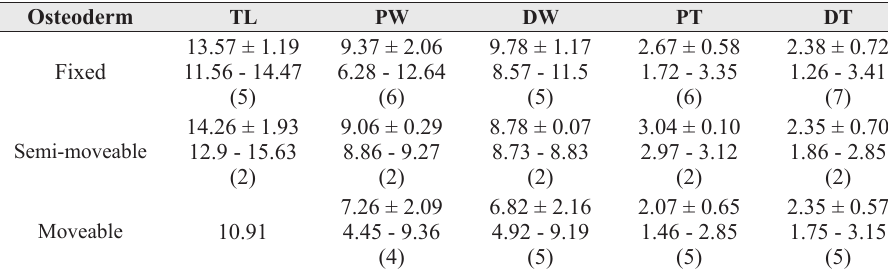
Measurements (mm) of preserved osteoderms assigned to Euphractus sexcinctus . Abbreviations: TL, total length; PW, proximal width; DW, distal width; PT, proximal thickness; DT, distal thickness. When n >1, first line is mean ± standard deviation, second line is observed range, and third line is number of specimens measured